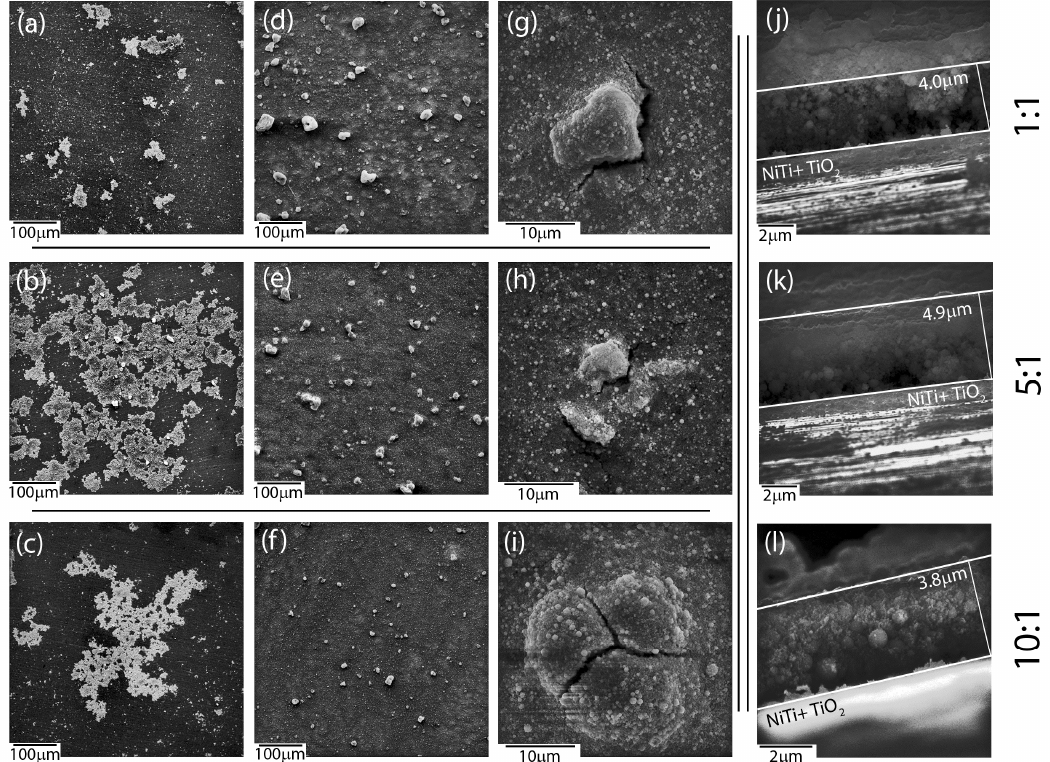
Figure 1. Scanning electron microscopy (SEM) images of coatings deposited under di ff erent conditions with di ff erent HAp: nSiO 2 / Ag ratios: 1:1 20 V / 60 s ( a ), 5:1 20 V / 60 s ( b ), 10:1 20 V / 60 s ( c ), 1:1 50 V / 240 s ( d ), 5:1 50 V / 120 s ( e ), 10:1 40 V / 90 s ( f ), 1:1 60 V / 120 s ( g ), 5:1 60 V / 120 s ( h ), 10:1 60 V / 120 s ( i ). Cross-sectional images of samples: 1:1 50 V / 240 s ( j ), 5:1 50 V / 120 s ( k ) and 10:1 40 V / 90 s ( l ).